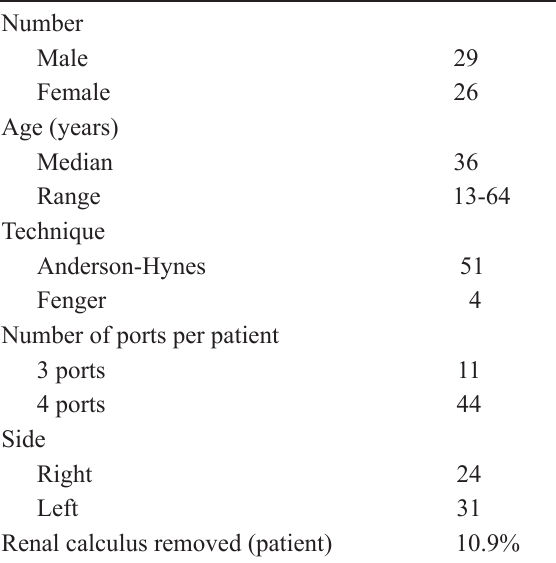
Table 1 – Summary of patient and surgical characteris- tics.